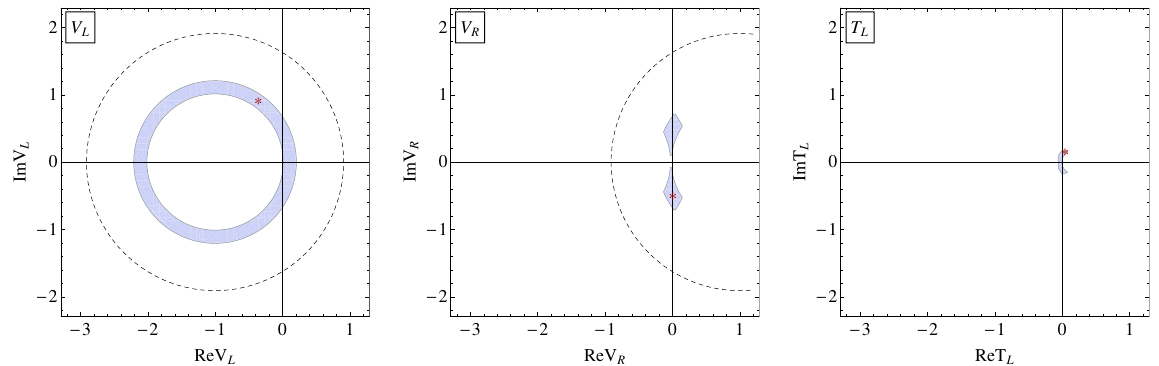
Figure 5. Constraints on the complex Wilson coefficients V L ( left ), V R ( center ), and T L ( right ) from the ( B → D ∗ τν τ ) within 2 σ , and from the branching fraction measurements of R D , R D ∗ , R J / ψ , and F D ∗ L B ( B c → τν τ ) ≤ 10% (dashed curve). The allowed regions are indicated in gray color. The asterisk symbols indicate the best-fit